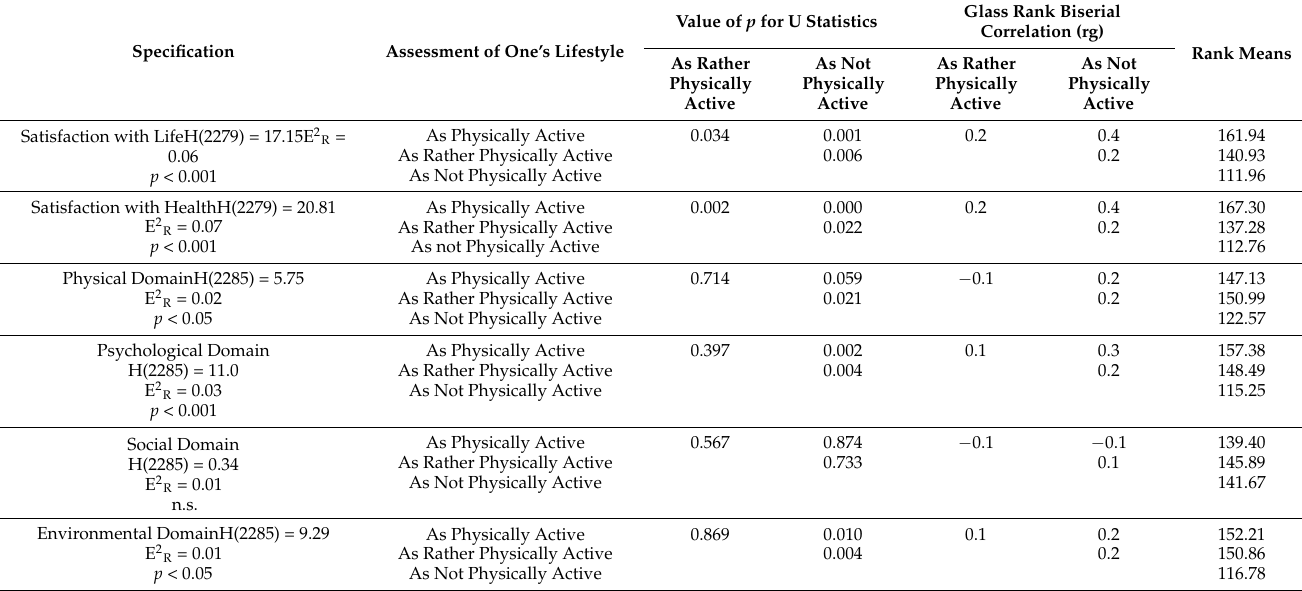
Table 3. Satisfaction with life, health, and particular domains of quality of life (WHOQOL-REF) of female students by a physically active or not physically active lifestyle (U test, rg).